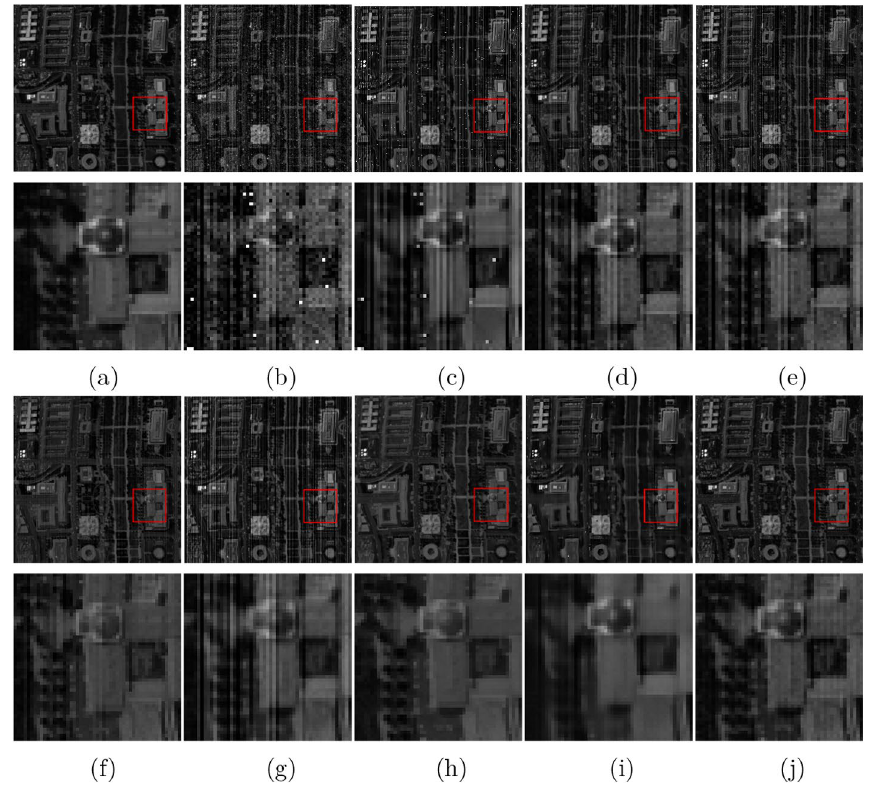
Fig. 2 The Washington DC Mall image (2nd band) [top] and zoom-in image [bottom] before and after denoising in Case 2.2 with σ the denoising results obtained by c BM4D; d LRMR; e NAILRMA; f LLRGTV; g MTGSNMF; h SSTVSSLR; i HSI-SDeCNN; j SRGLR (proposed)